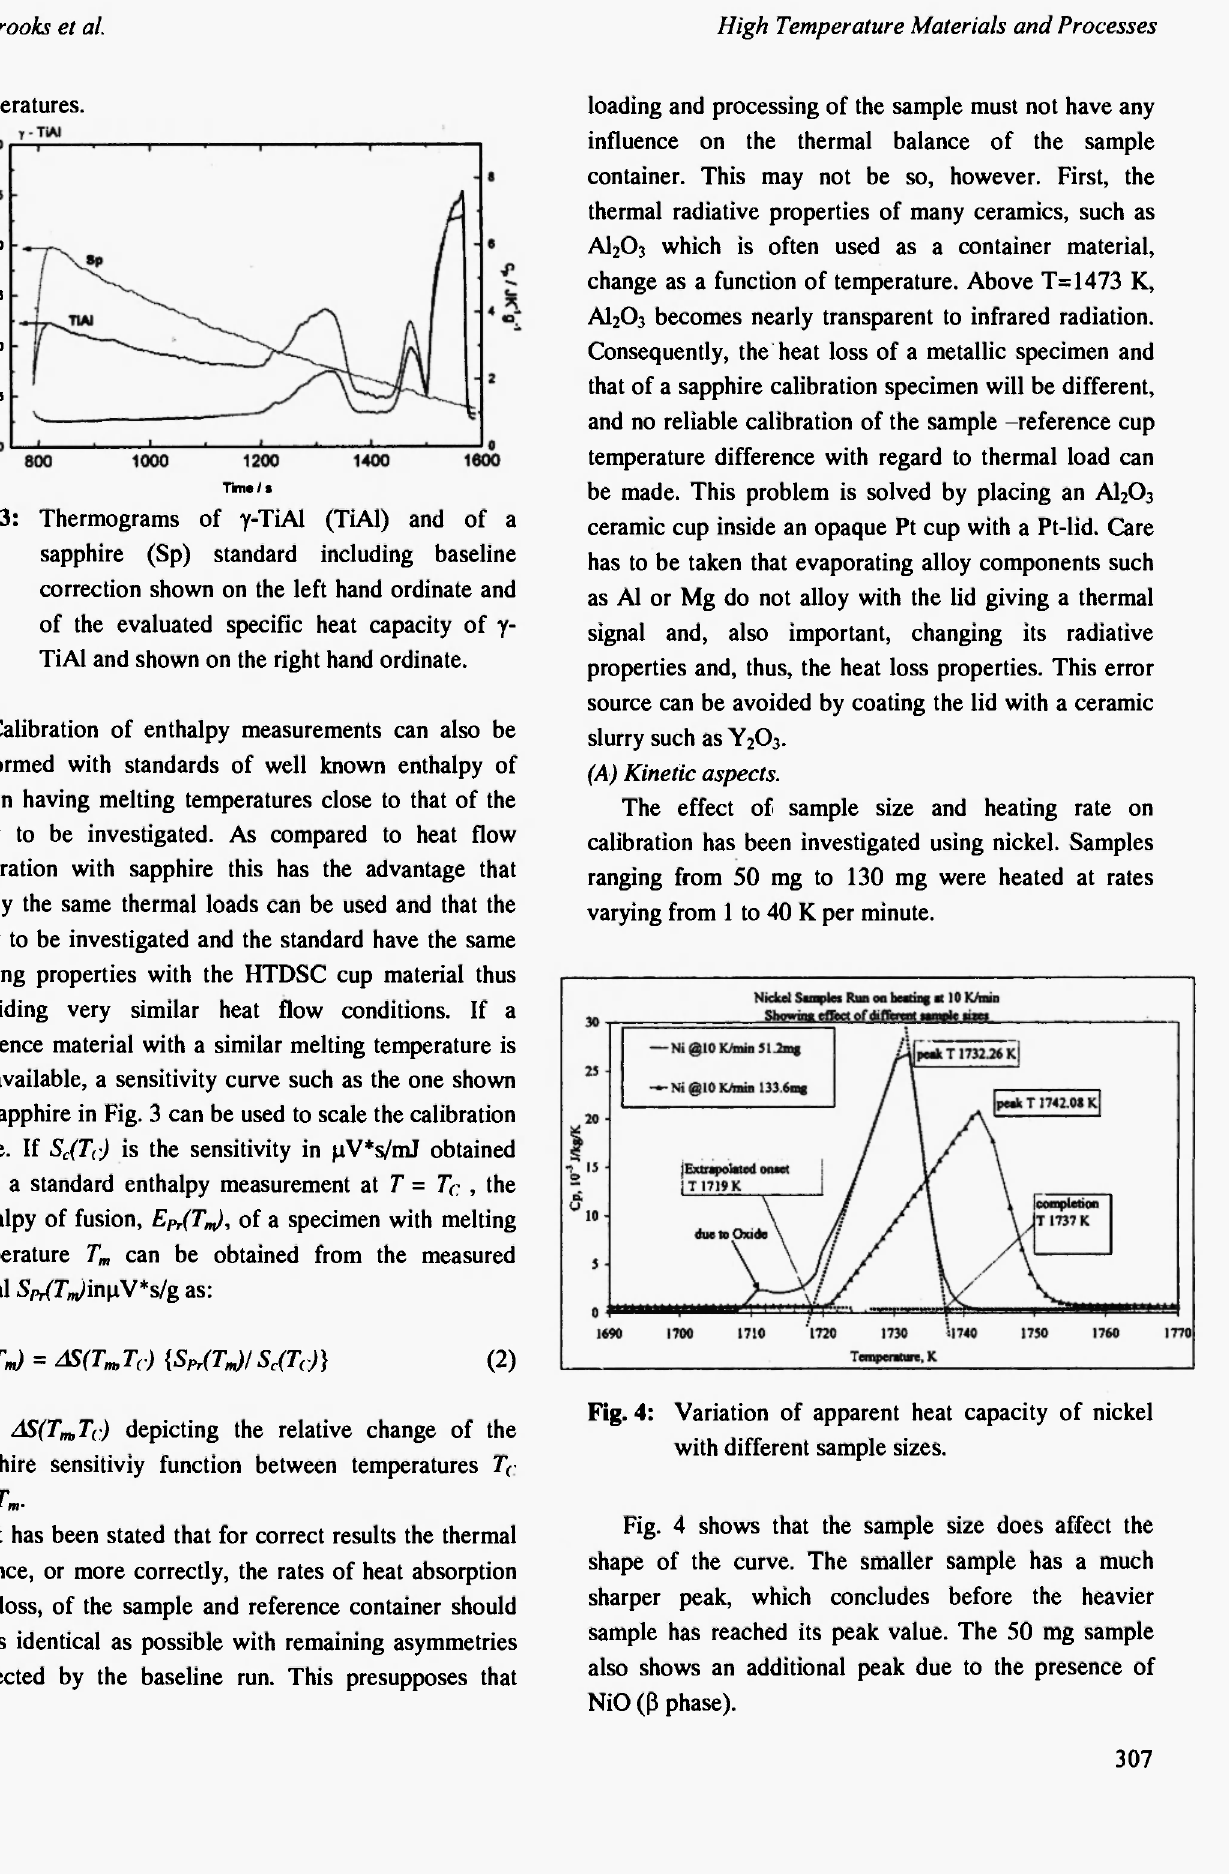
Fig. 4: Variation of apparent heat capacity of nickel with different sample